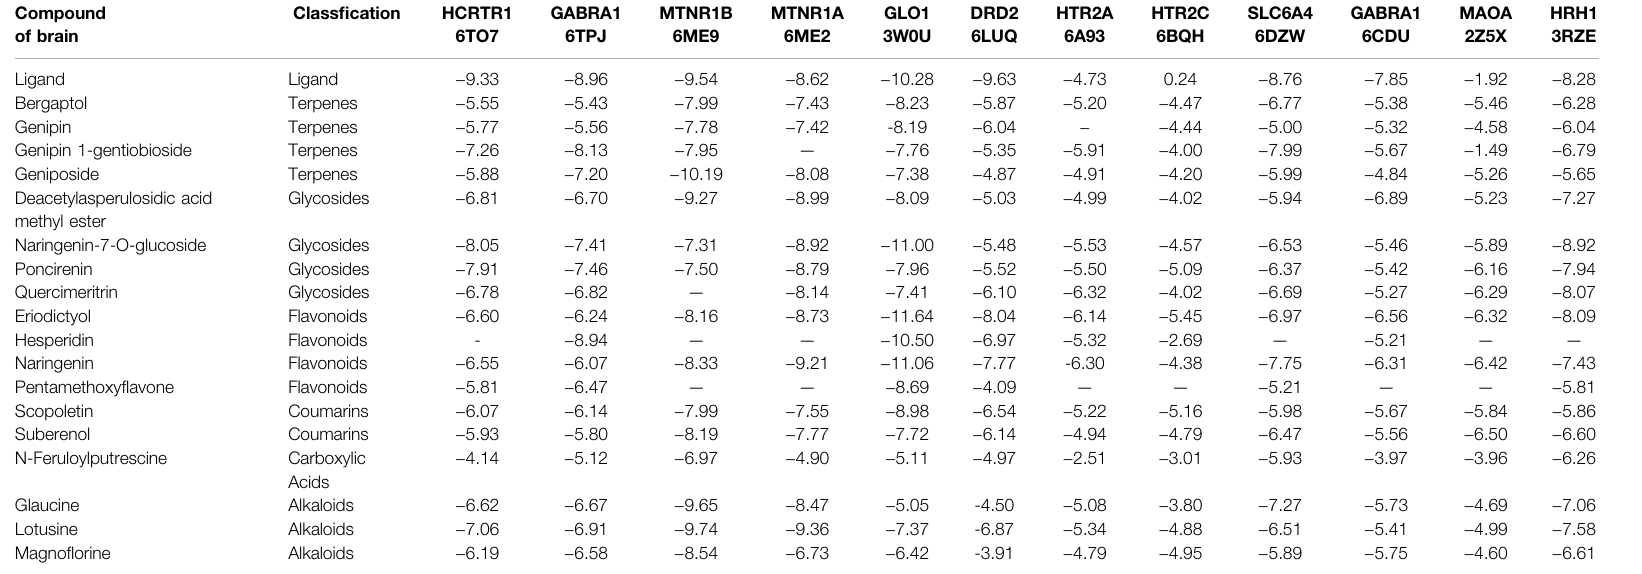
TABLE 2 | Molecular docking results of 18 prototype components absorbed into the brain from Zhi-Zi-Hou-Po decoction. Compound of brain